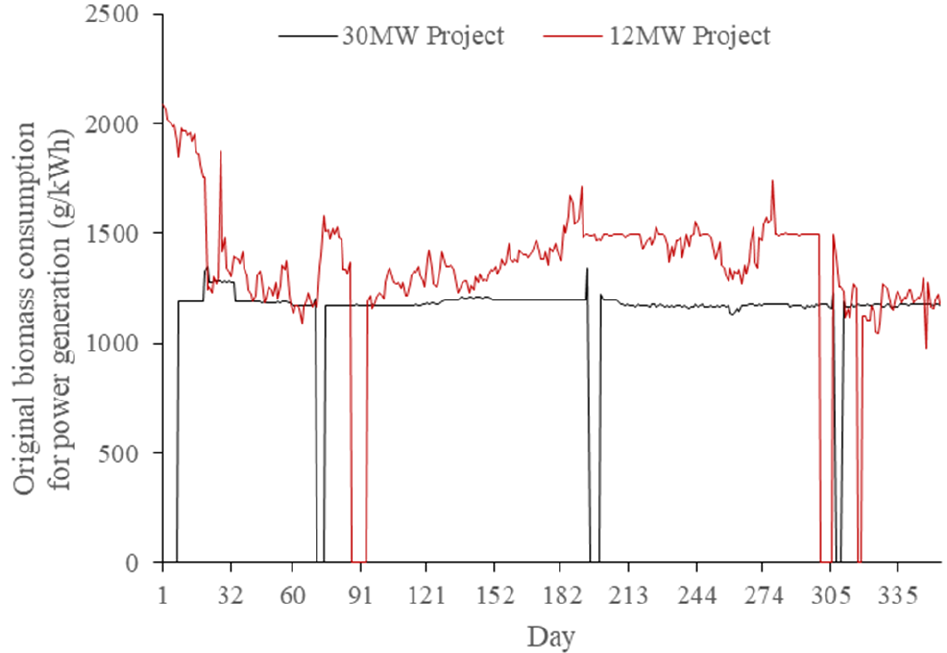
Figure 3. Original biomass consumption for power generation.